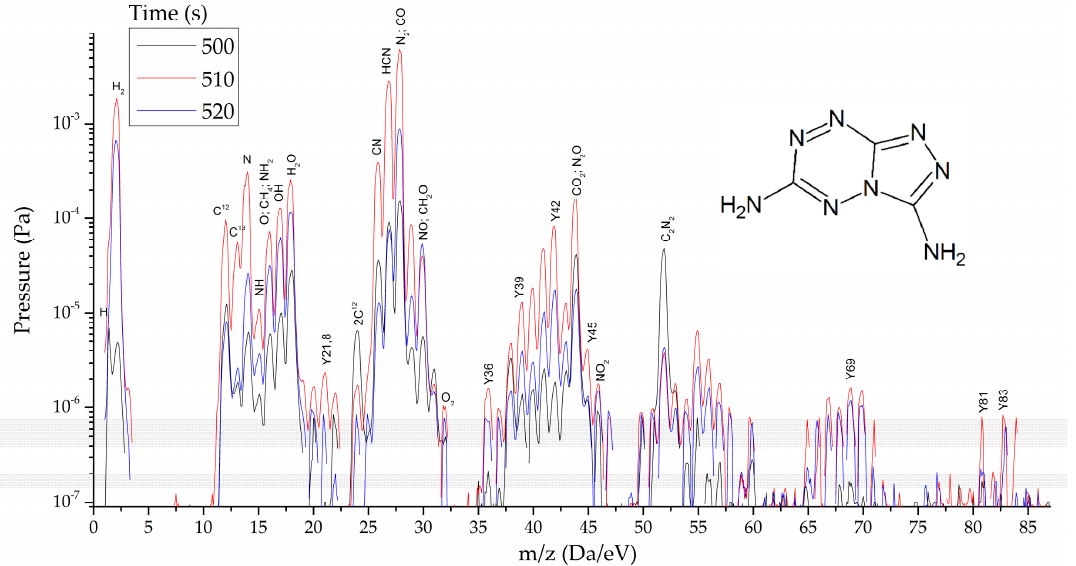
Figure 8. Mass spectra of gaseous products of TTDA reactions at the peak of decomposition at heating rates from 1.5 to 2000 s − 1 .